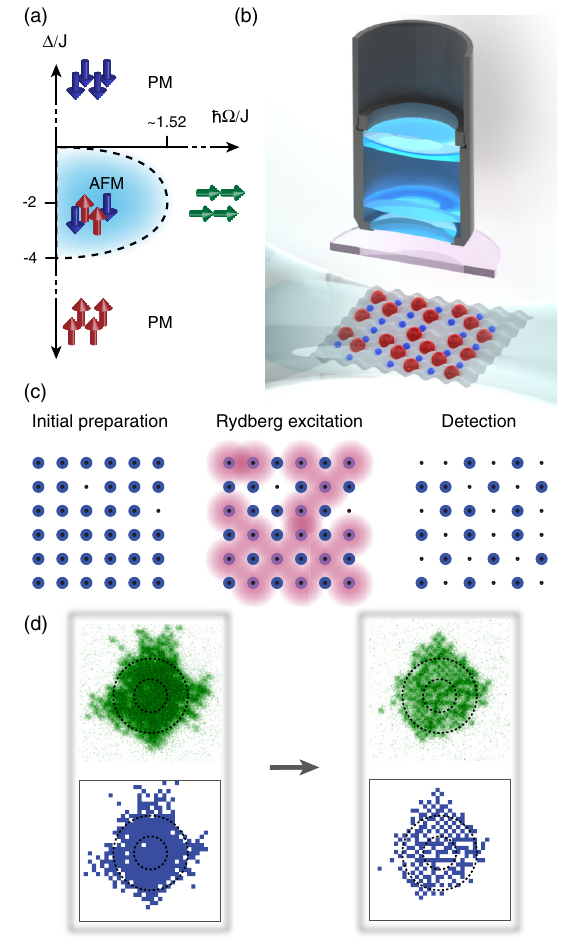
FIG. 1. Realization of a 2D quantum Ising model with Rydberg atoms in an optical lattice. (a) Ground-state phase diagram of the ˜ H; 2D quantum Ising model with nearest-neighbor coupling J . This is an approximate phase diagram of our Rydberg system when the blockade radius is comparable to the lattice spacing. Transverse and longitudinal fields are controlled by the Rabi frequency Ω and laser detuning Δ , respectively. There is only one ordered phase, the antiferromagnet (AFM). Outside of this region there is a paramagnetic (PM) phase where the spins align with the field. (b) Experimental setup consisting of a 2D array of atoms at the focus of a high-resolution objective, capable of resolving individual sites of the lattice. Atoms in the ground state (small blue spheres) are directly coupled to the 23 P Rydberg state (large red spheres) with 230-nm laser light. (c) Typical atom configu- rations at different stages of the experiment. The initial state consists of an array of atoms in the electronic ground state (blue, left). This state is quenched into a state with antiferromagnetic correlations (Rydberg atoms in red, center). By increasing the lattice depth, Rydberg atoms are lost and only the ground state atoms are imaged (right). (d) Raw fluorescence images of an initial (left) and a postquench (right) configuration with strong antiferromagnetic correlations, together with reconstructed im- ages (each blue pixel depicts a detected atom in the ground state). The annular region we used for analysis is shown delimited by dotted